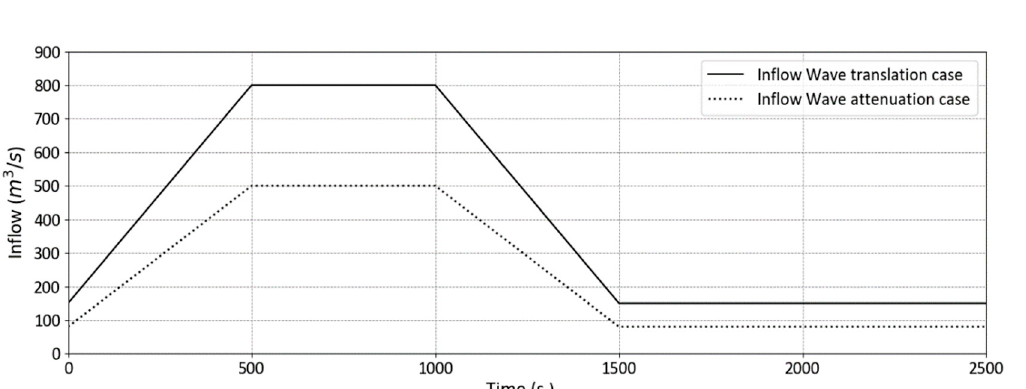
Figure 1. Inflow hydrograph at the upstream boundary: for wave attenuation and wave translation cases.